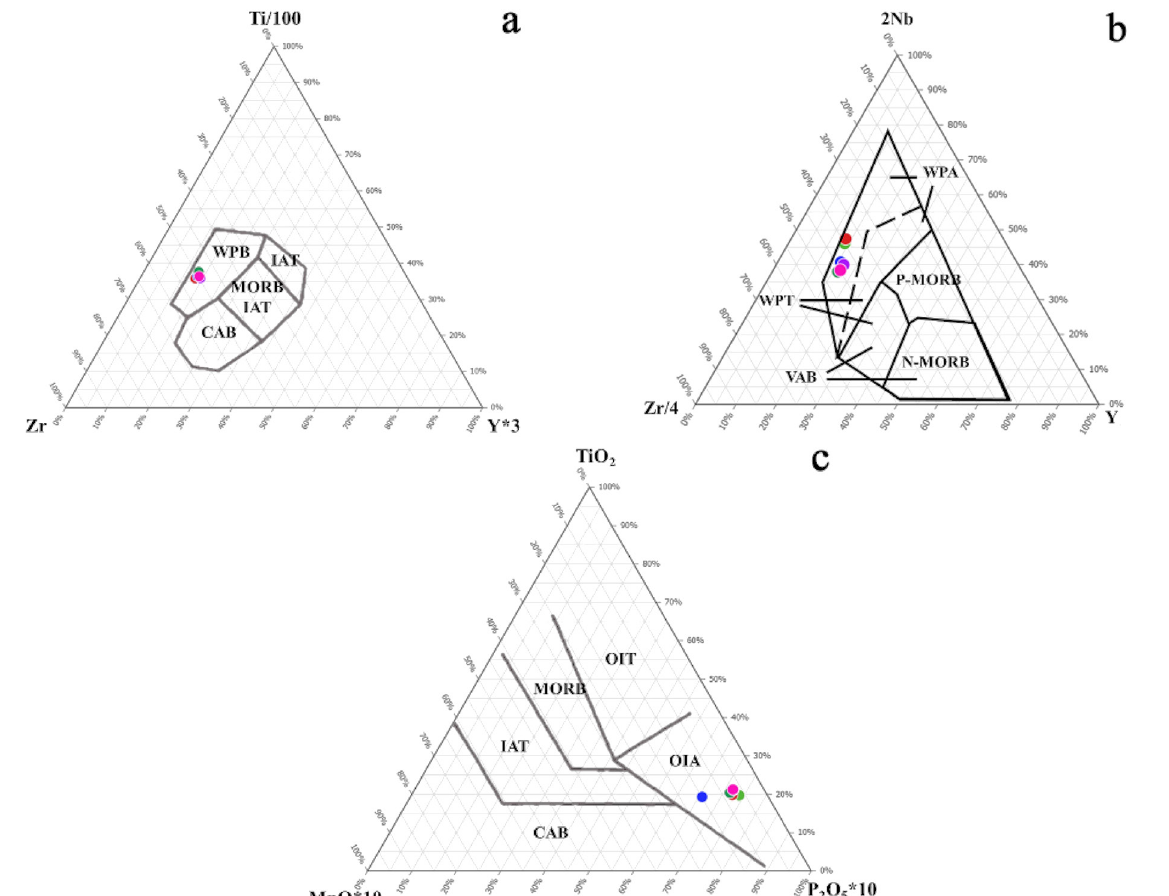
Fig. 5. The discrimination diagrams for the studied rocks; a – Ti–Zr–Y diagram, b – Nb–Zr–Y diagram, and c – TiO –MnO–P O diagram (diagram modified from Sun, McDonough 1989, Pearce, Cann 2 2 5